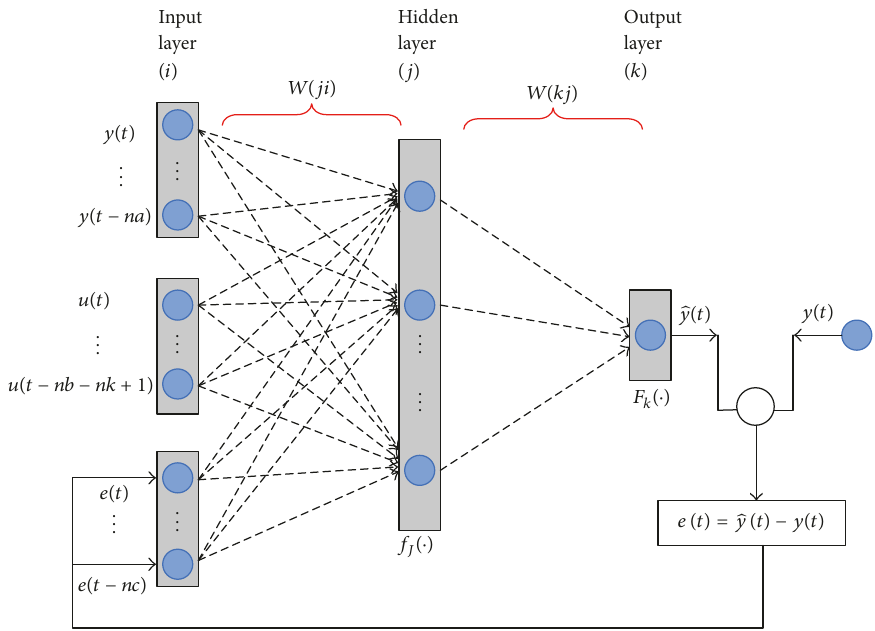
Figure 3: Autoregressive Average Moving-Neural Network (ARMANN)